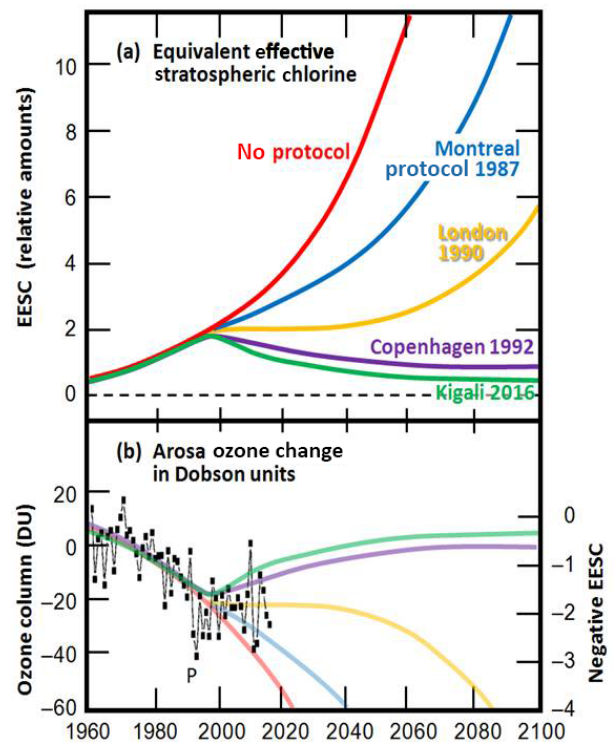
Figure 8. (a) Relative abundance of ozone-depleting substances (ODSs, i.e. volatile halocarbons) expressed as equivalent effec- tive stratospheric chlorine (EESC) for the mid-latitude stratosphere, shown for various scenarios (demonstrating the impact of the Mon- treal Protocol and its subsequent Adjustments and Amendments). EESC can be viewed as a measure of chemical ozone depletion by ODSs and takes into account the temporal emission of the individual ODS species as well as their ozone depleting potential. (b) Arosa annual mean ozone columns (black symbols, as in Fig. 7) in com- parison with the scenarios in panel (a) . “P” marks the eruption of Mt. Pinatubo in 1991, which has aggravated the ozone